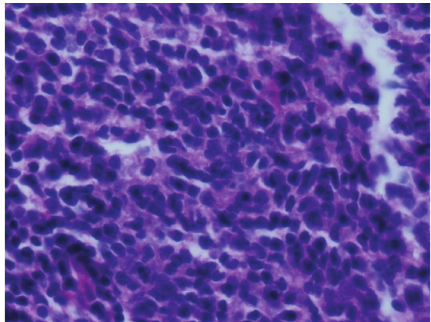
Figure 2: Follicular lymphoma of the breast at 40x magnification in hematoxylin and eosin stain.